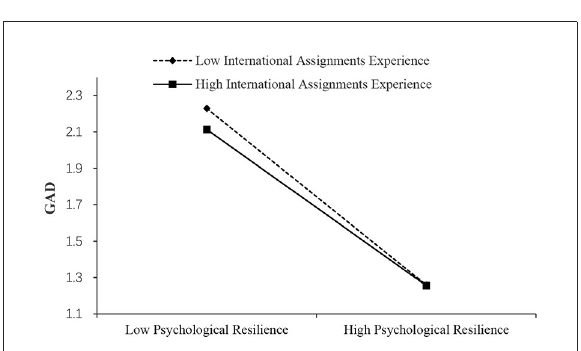
FIGURE5 Simple slopes of international assignments experience moderate the effect of psychological resilience on